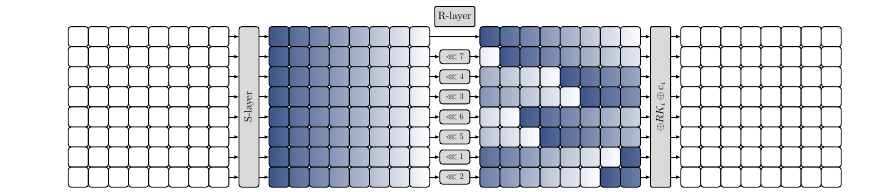
Figure 8: Round function of PIPO